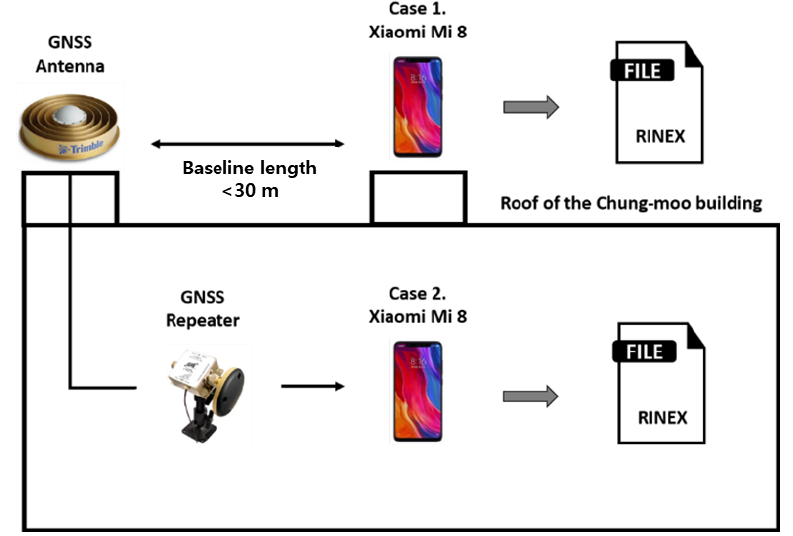
Figure 1. Test configuration for comparison of noise-level with or without GNSS repeater.